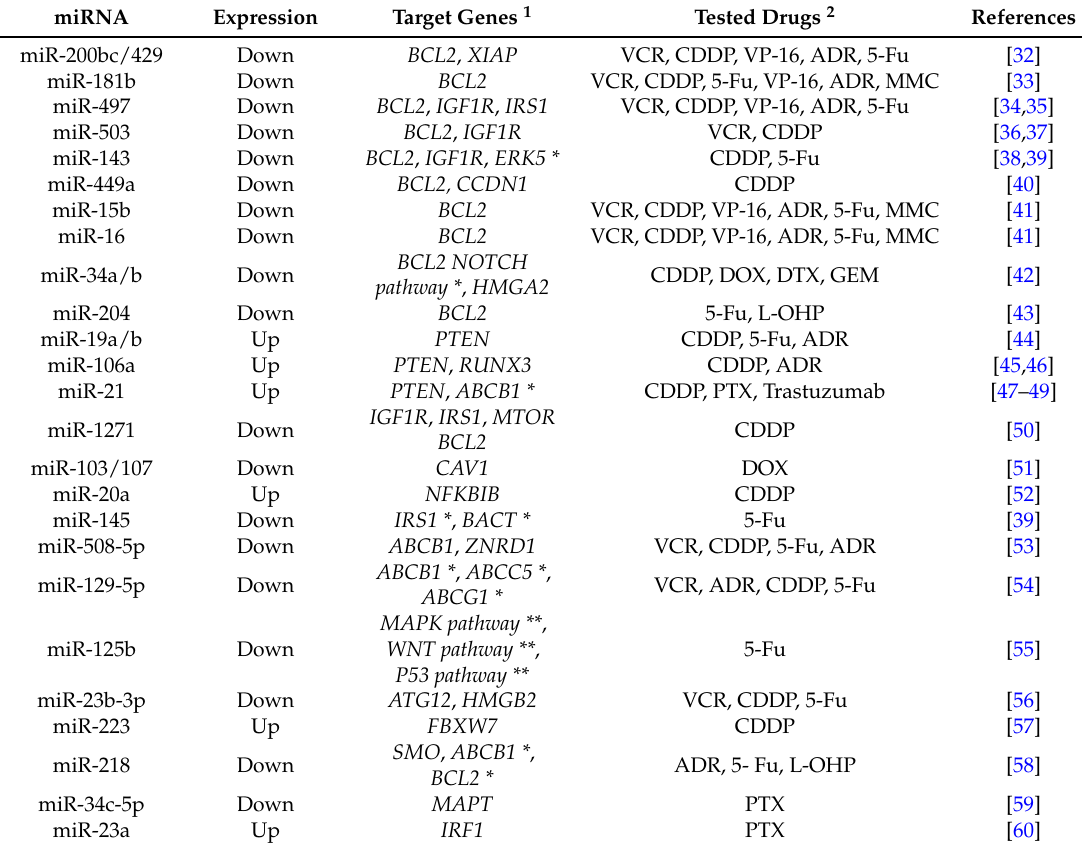
Table 1. MicroRNAs involved in drug resistance of gastric cancer